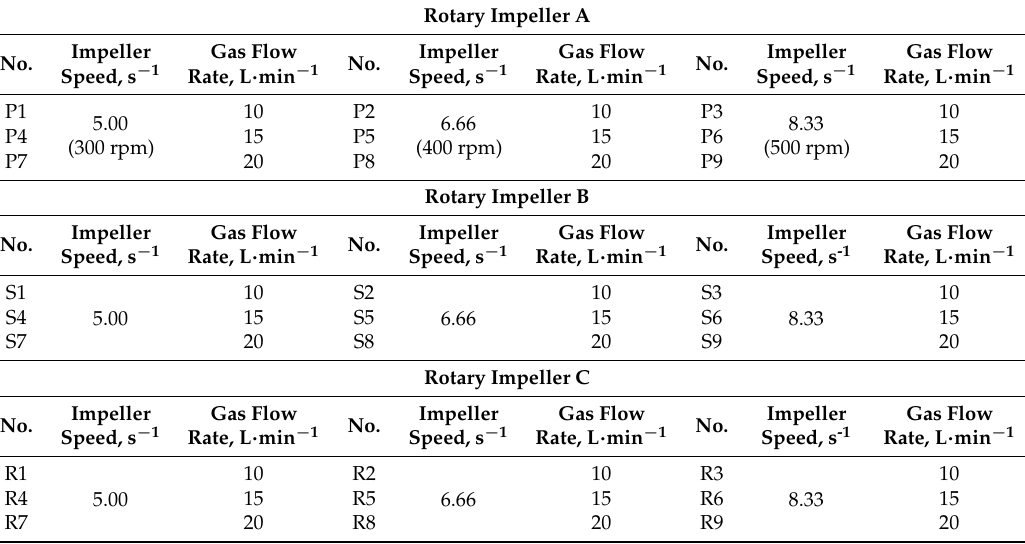
Table 2. Experimental variables for water physical